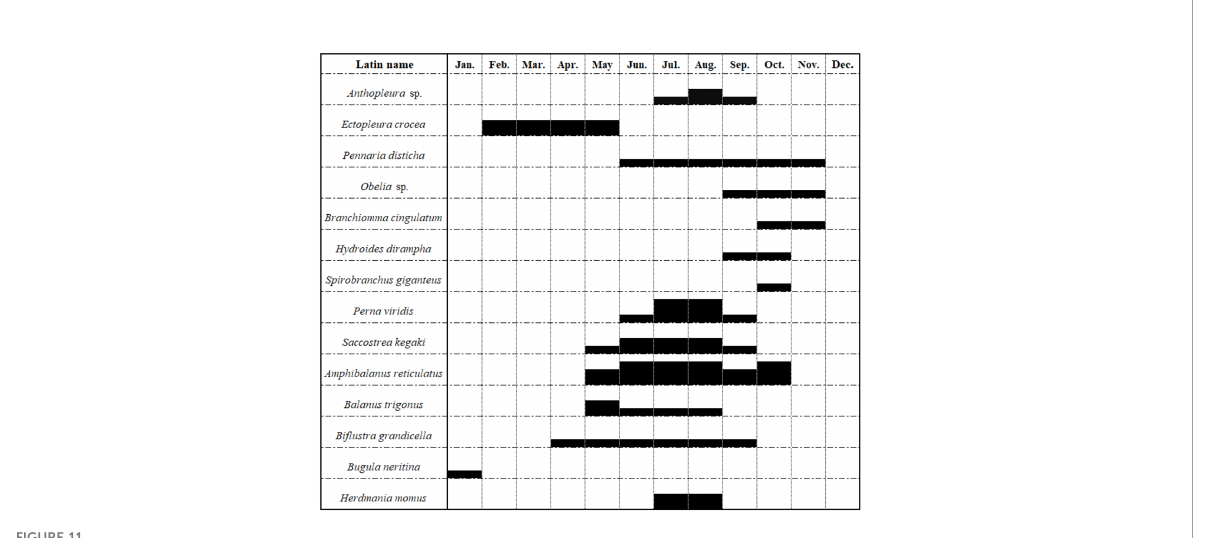
FIGURE 11 The attachment period of the major